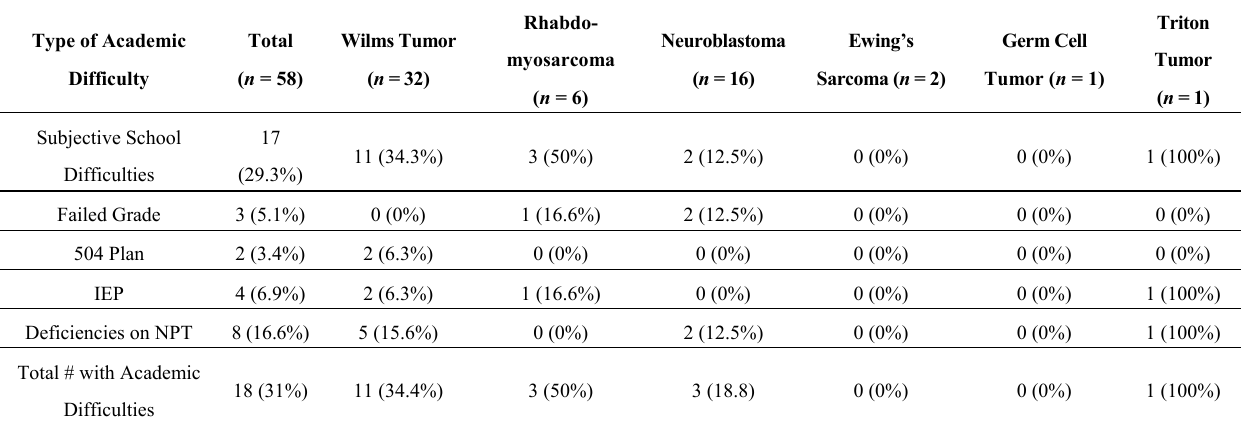
Table 2. Academic difficulties experienced by young extracranial solid tumor